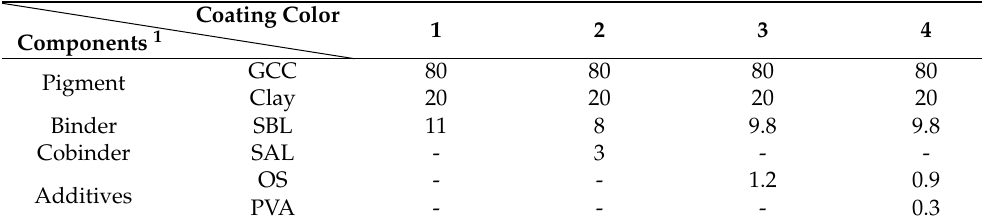
Table 2. Formulations of coating colors for evaluating the effect of acrylate monomers of latex, starch, and PVA on the tensile strength of coating layers.